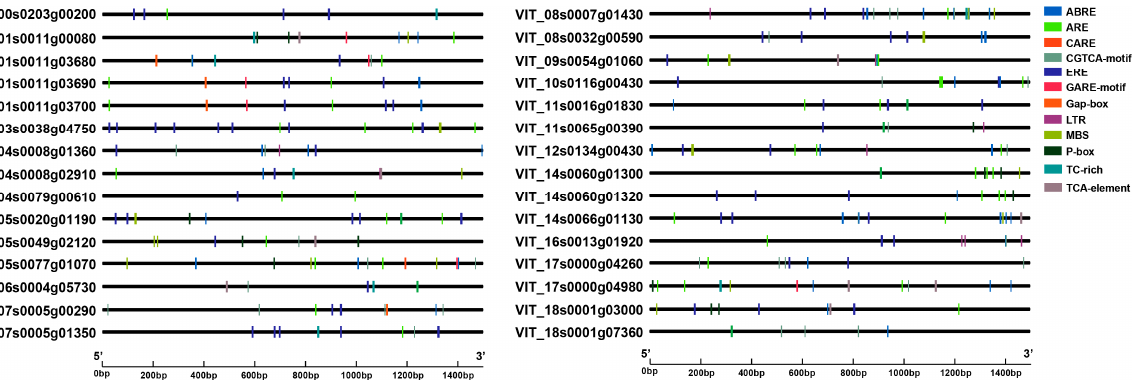
Figure 4. Promoter analysis of the VvUSPs . The promoter analysis of VvUSPs was performed on 1500 bp sequences upstream from their transcription start sites.